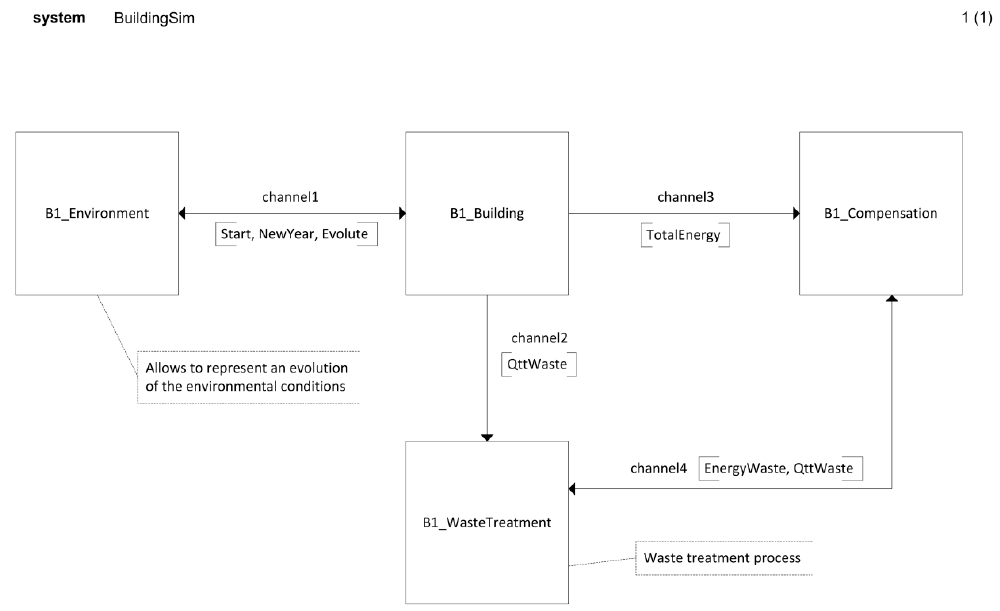
Figure 2. System diagram of the SDL model. The complete model can be reviewed in [36]; the figure